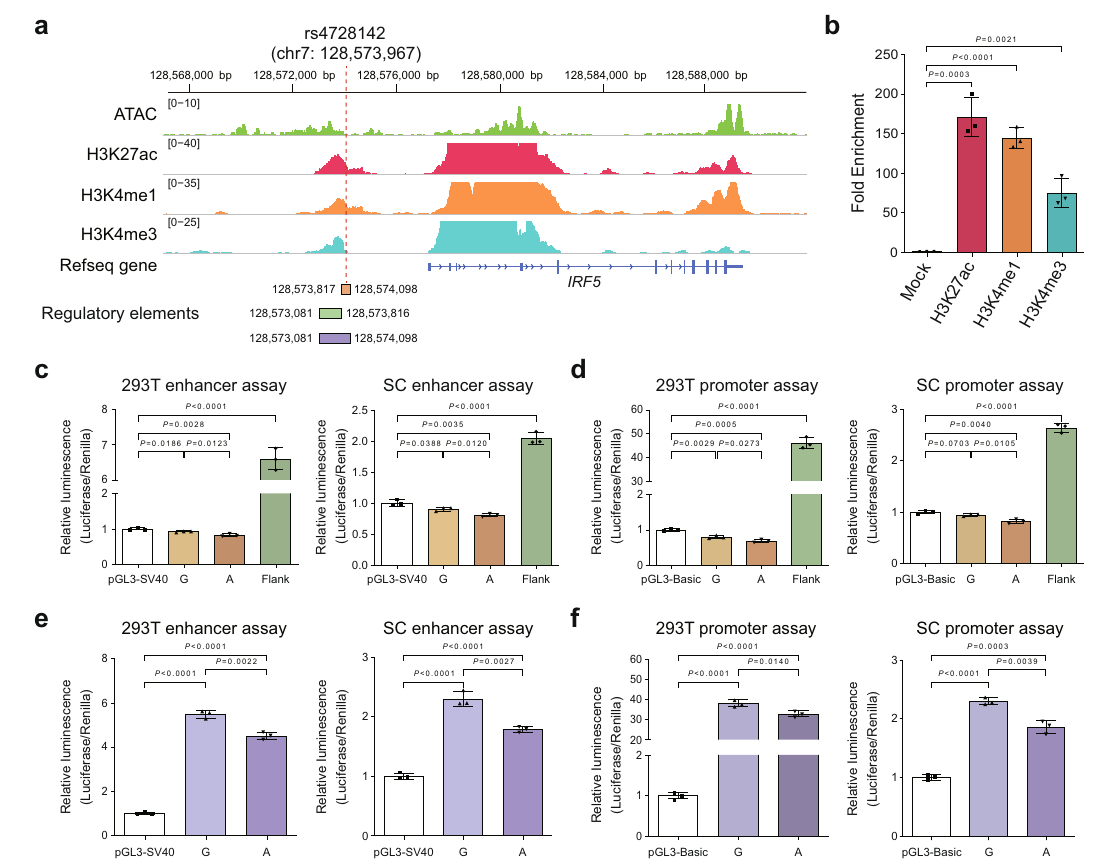
Fig. 2 | rs4728142 affects the activity of a promoter-like enhancer adjacent to IRF5 promoter. a Assay of Transposase Accessible Chromatin sequencing (ATAC- seq), and H3K27ac, H3K4me1, and H3K4me3 Chromatin immunoprecipitation fol- lowed by sequencing (ChIP-seq) signals at the interferon regulatory factor 5 ( IRF5) nearby region in SC cells, a human monocyte-derived cell line with heterozygote alleles (the nonrisk allele G and the risk allele A) at rs4728142. Red dotted line denotesthers4728142location.Sequencelocationinformation(GRCh37/hg19)for regulatory elements (includingthe rs4728142-containing sequence, the rs4728142- associated upstreamenhancersequence,and theintegrated sequence)used inthe luciferase assays is shown at the bottom of the graph. b ChIP enrichments of H3K27ac,H3K4me1,andH3K4me3atthers4728142-containingregioninSCcellsas determined by ChIP-qPCR. c , d Luciferase reporter assays utilizing vectors